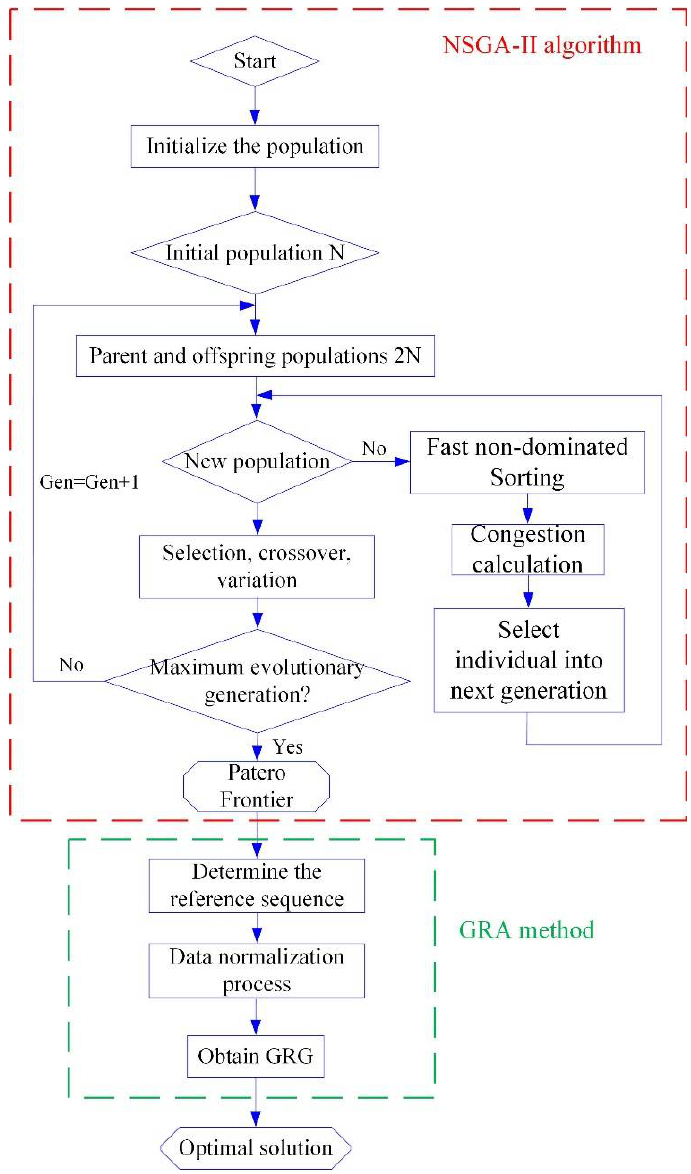
Figure 4. Flow chart of multi-objective optimization of ISFBD.